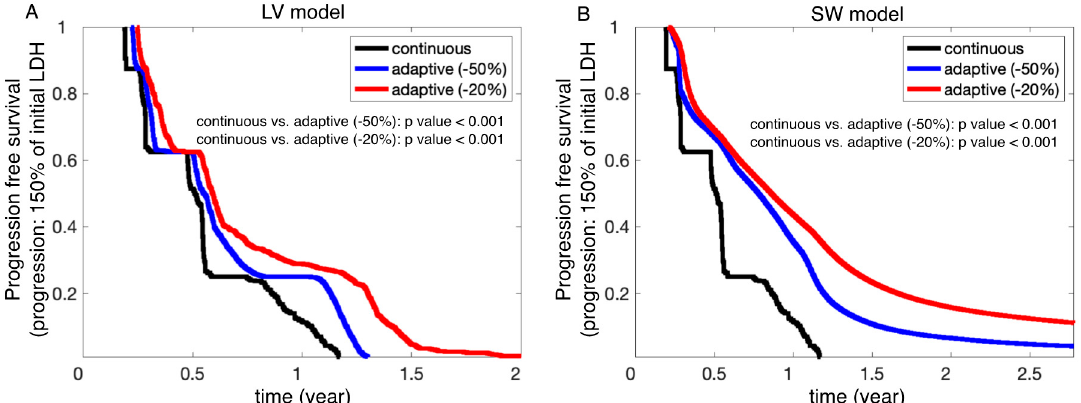
Figure 6. Progression-free survival comparison. ( A ) The LV model predicted progression-free survival under continuous therapy (black) and two different adaptive therapy stopping thresholds ( − 50%: blue and − 20%: red). The survival proba- bilities are significantly different ( p -values < 0.001). ( B ) The SW model predicted progression-free survival under continu- ous (black), − 50% adaptive (blue), and − 20% adaptive (red) therapies. The survival probabilities are significantly different ( p -values < 0.001).